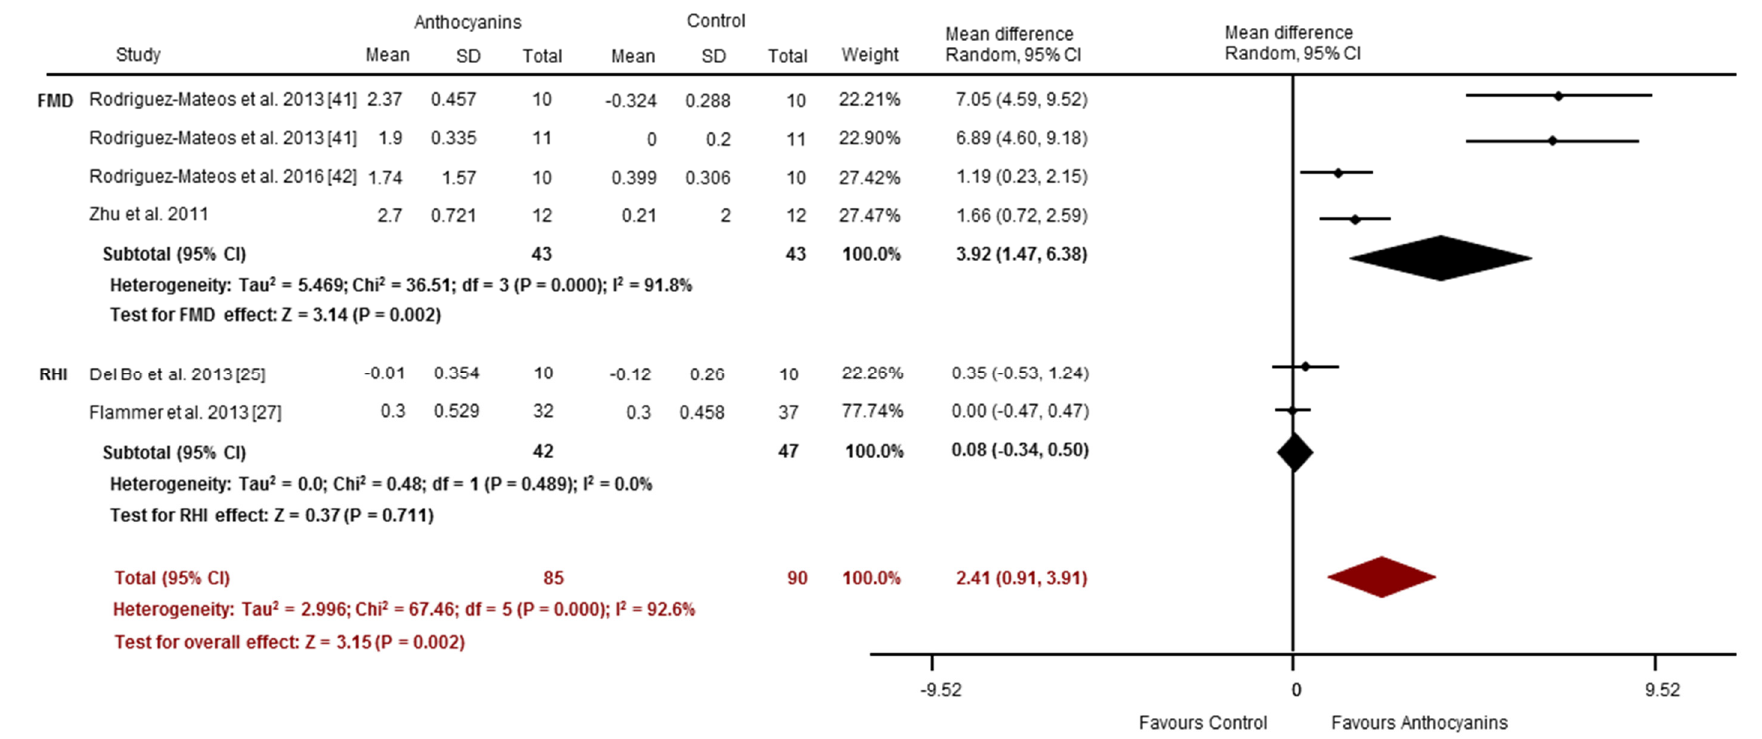
Figure 3. Acute effects of anthocyanins relative to control for vascular reactivity (assessed via FMD and RHI). The forest plot has one line representing each study in the meta ‐ analysis, plotted according to the mean difference (indicated by the black diamond in each line). The horizontal line joins the lower and upper limits of the 95% CI of these effects. The black diamond at the bottom of each graph represents the average effect size for FMD and RHI studies. The red diamond represents the average effect size for all studies assessing vascular reactivity.